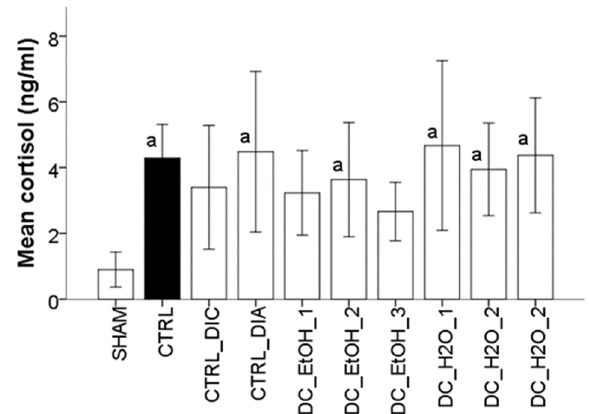
Figure 5. Effect of Dichrostachys cinerea fruit extracts on serum cortisol in CFA-induced arthritic rats. Serum inflammatory cytokines values are expressed as mean ± standard error of the mean (n = 10). Superscript ‘a’ indicates a significant difference ( p < 0.05) as compared to the SHAM group as performed by one-way ANOVA, Tukey’s multiple comparisons